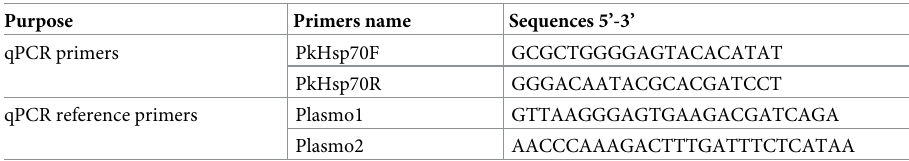
Table 1. List of primers used in quantitative